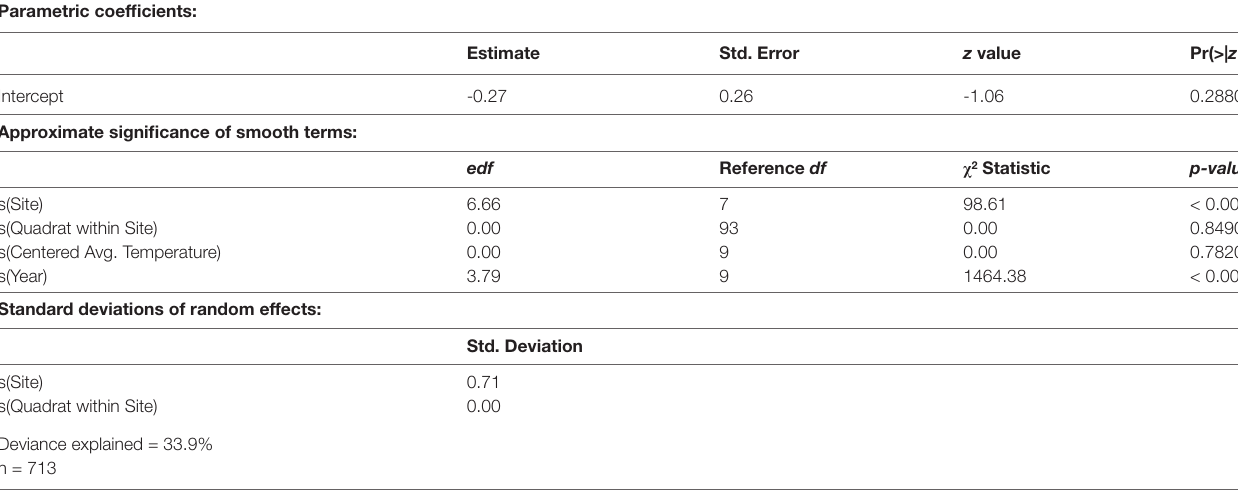
TABLE 3 | Eelgrass abundance, given presence, component GAMM (beta response distribution with logit link function)